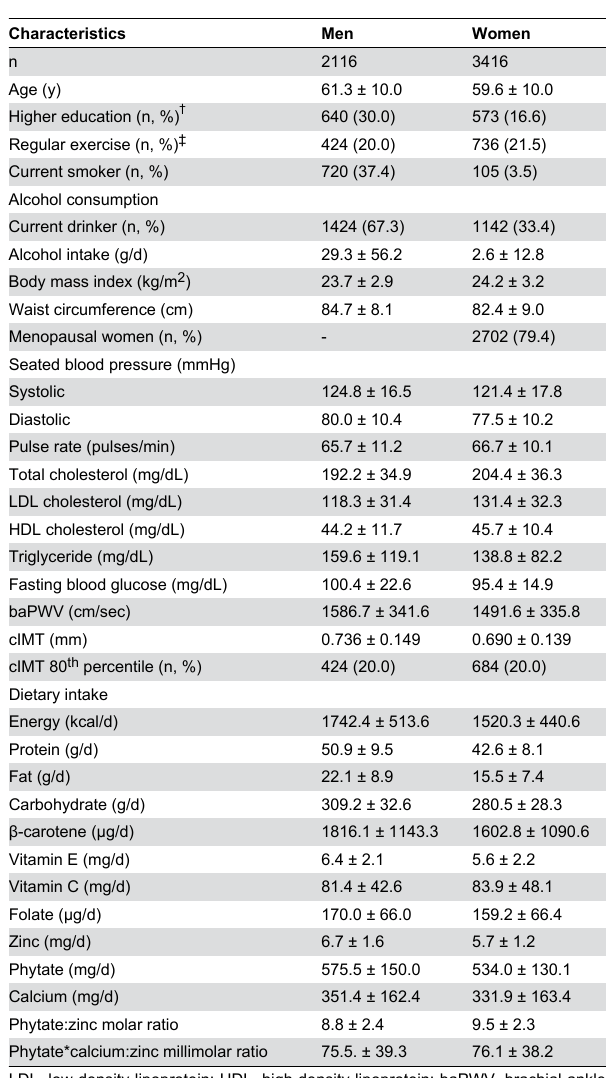
Table 1. General characteristics of the study